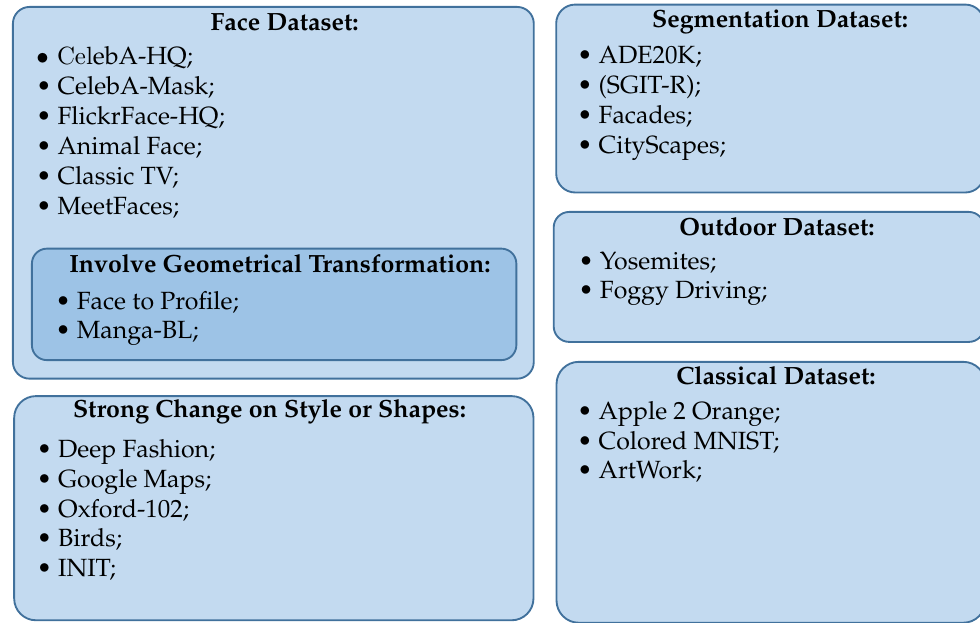
Figure 2. Dataset organization where we classify datasets given the main